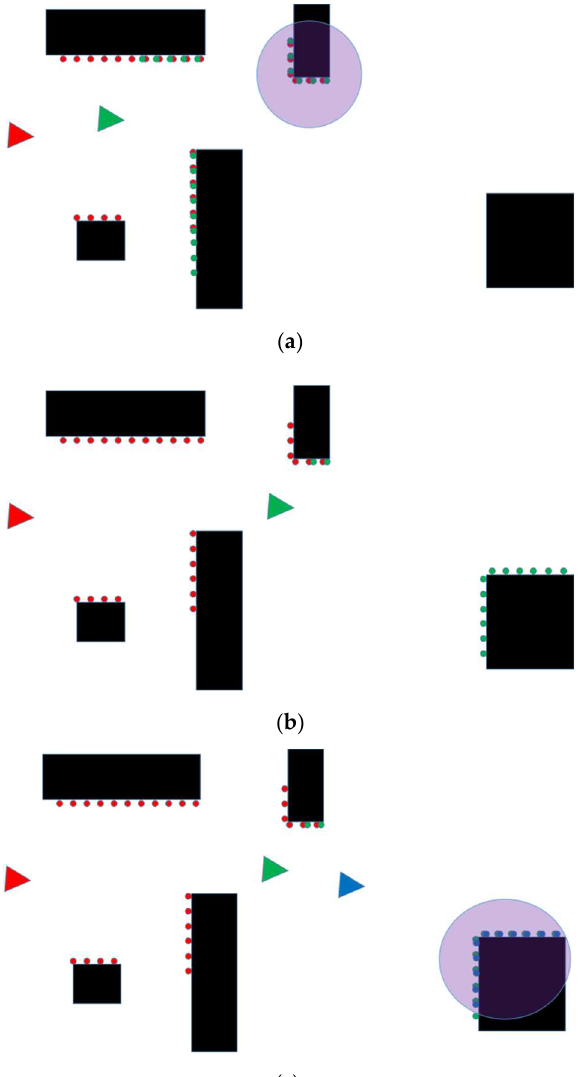
Figure 4. Reference frame and landmark update. ( a ) Initial attention area. Red is the reference frame, green is current frame, and the purple area is the current landmark; ( b ) attention area switching. The current landmark is close to the robot; ( c ) the attention area is switched, and blue is the newest frame, and the purple area is the new selected landmark.